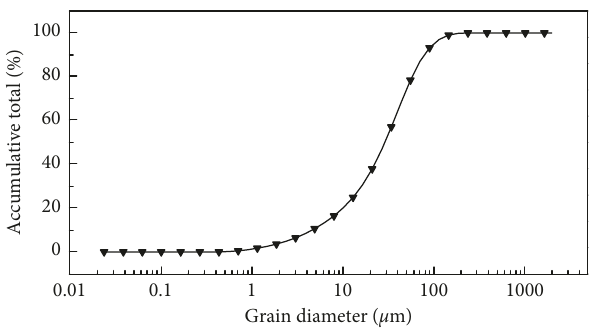
Figure 4: Particle size distribution of loess soil.